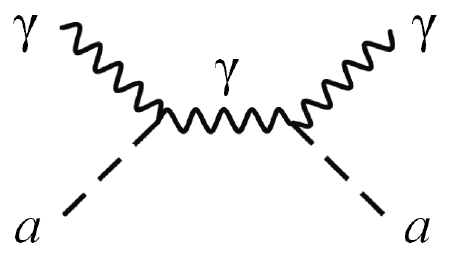
Figure A1. Feynman diagram for the a γ → a γ scattering.